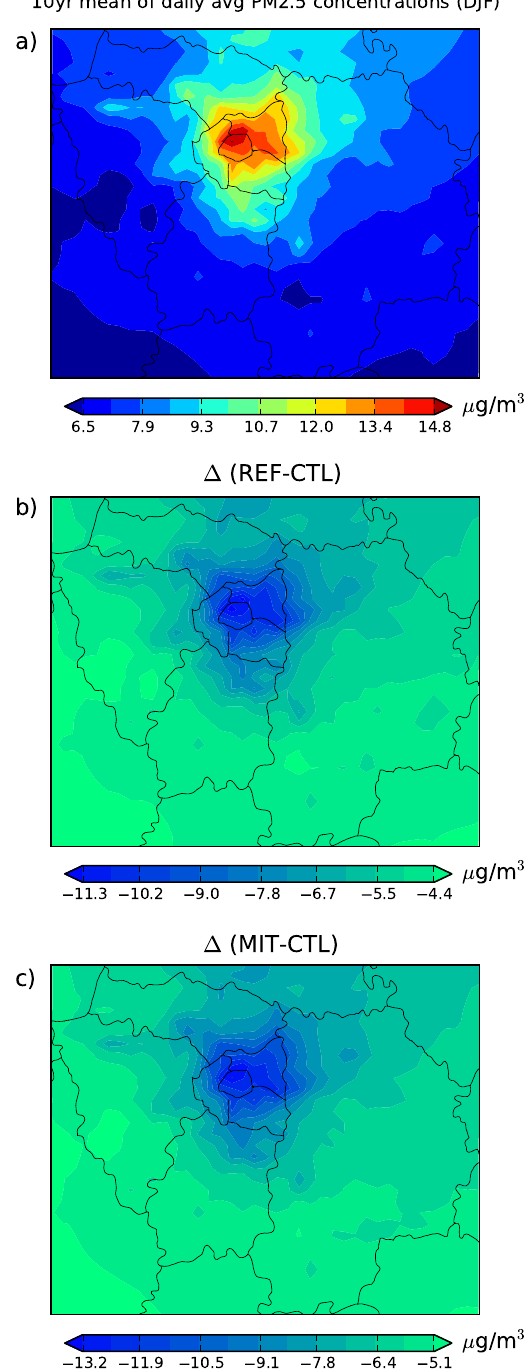
Figure 7. Wintertime (DJF) PM 2 . 5 daily average fields (µgm − 3 ) for the control simulation (a) and the differences between the latter and the REF (b) and MIT (c) future